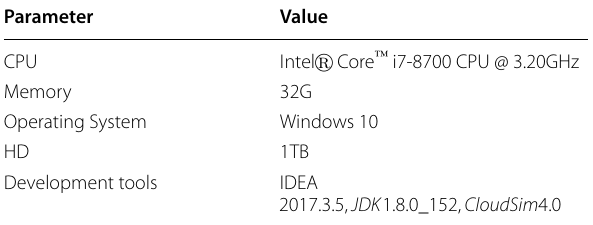
Table 1 Experimental